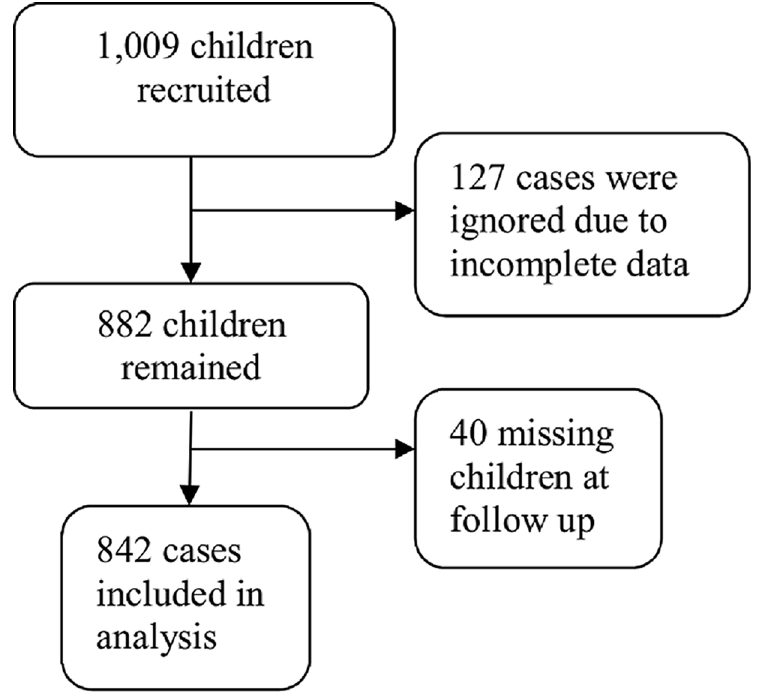
Fig 1. Children retained in the study sample for complete case analysis.